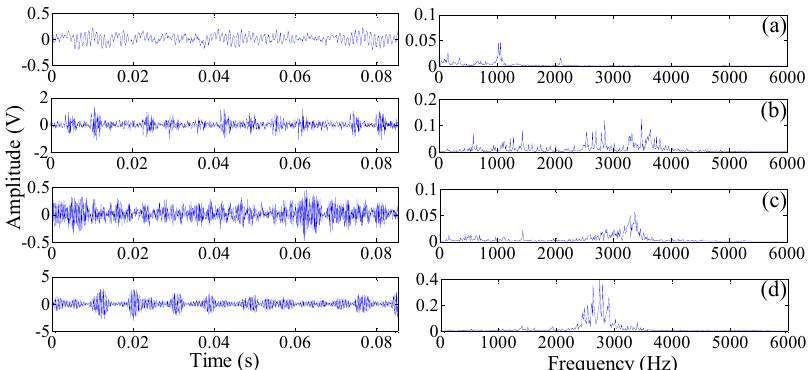
Figure 6. Example of the original signals and their spectra for each health condition ( a ) normal-bearing signal; ( b ) inner race fault-bearing signal; ( c ) ball fault-bearing signal; and ( d ) outer race fault-bearing signal.